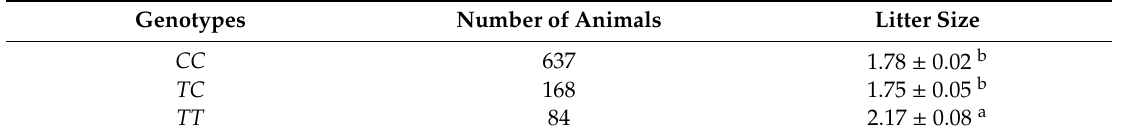
Table 2. Association between genotypes carrying the g.727C > T polymorphism of the ovine LH β gene and litter size.